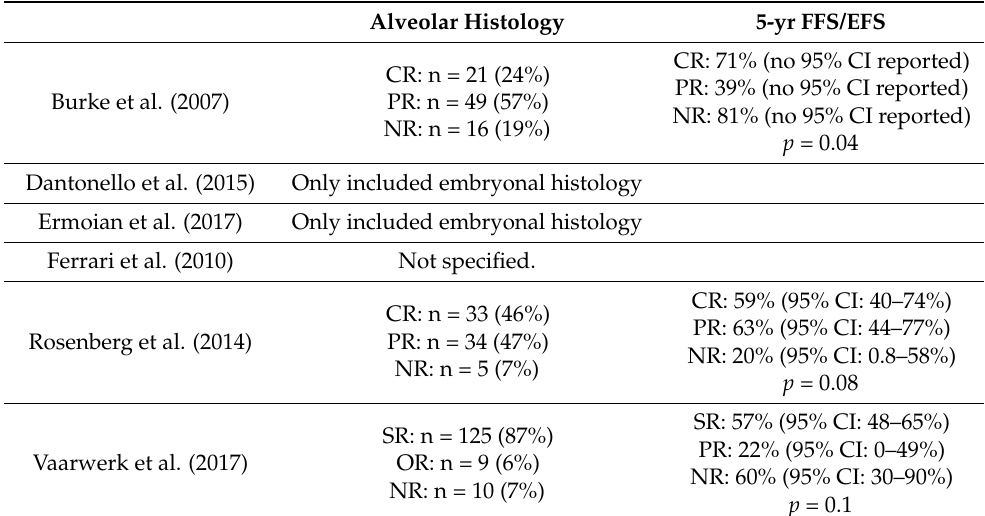
Table A2. Survival and Response Specified for Alveolar